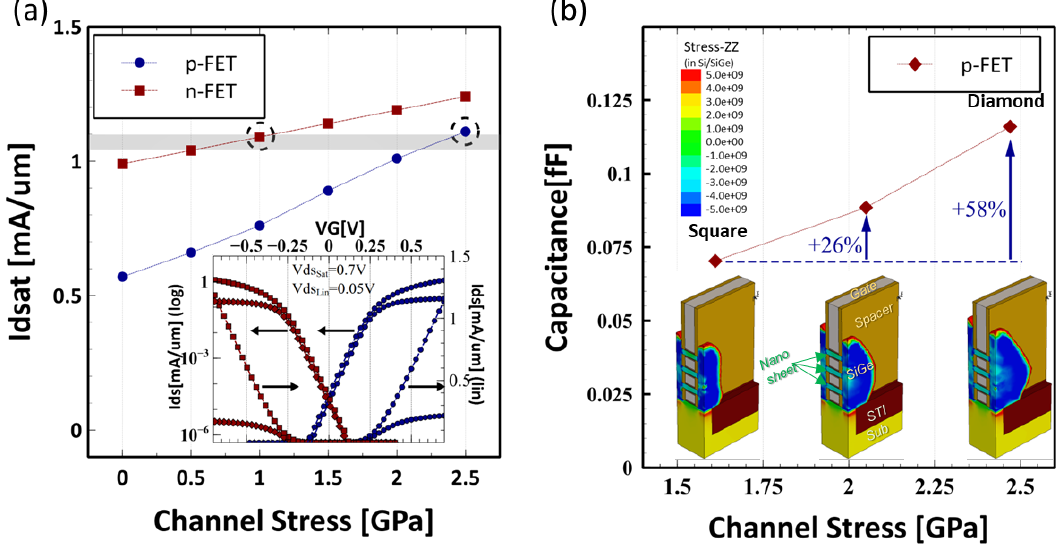
Figure 1. ( a ) Idsat response curve versus Channel stress for NS-FETs, with n-FET @ 1.0 GPa and p-FET @ 2.5 GPa, good N/P current matching is achieved; ( b ) capacitance versus stress for different S/D EPI sizes. The high stress EPI volume comes with capacitance